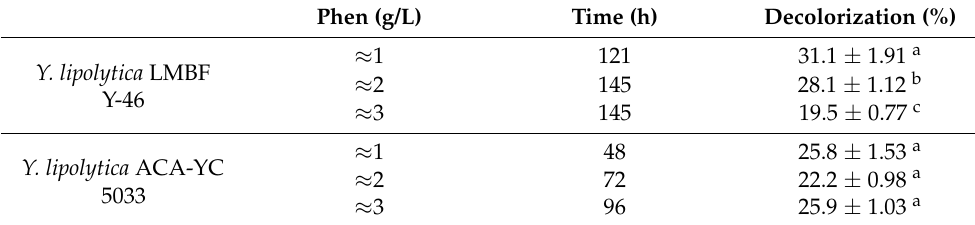
Table 3. Decolorization (%) of the fermentation media achieved by Y. lipolytica LMBF Y-46 and ACA-YC 5033 on blends of olive mill wastewater (OMW) and crude glycerol under nitrogen-limited conditions in shake-flask fermentations. The blends of OMW-glycerol were properly formulated to have different initial phenolics concentrations (Phen) of ca. 1 g/L, 2 g/L, and 3 g/L. Different letters within the same column (with respect to the same yeast strain) indicate statistically significant differences ( p < 0.05). Phen (g/L) Time (h) Decolorization (%) Y. lipolytica